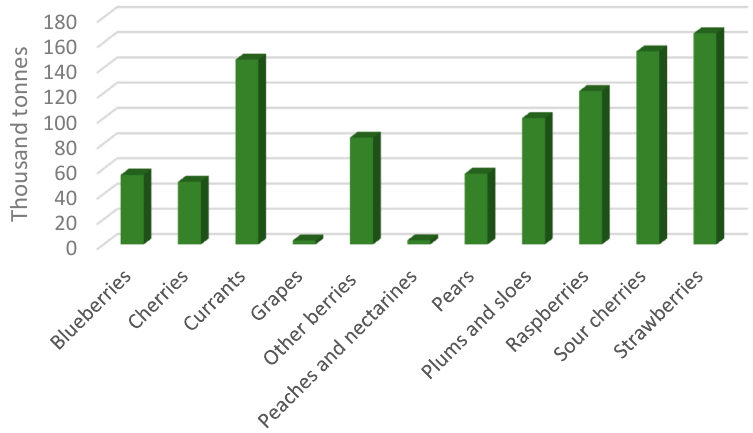
Figure 5. Polish fruit production in 2020 (data from fao.org) (accessed on 12 October 2022).